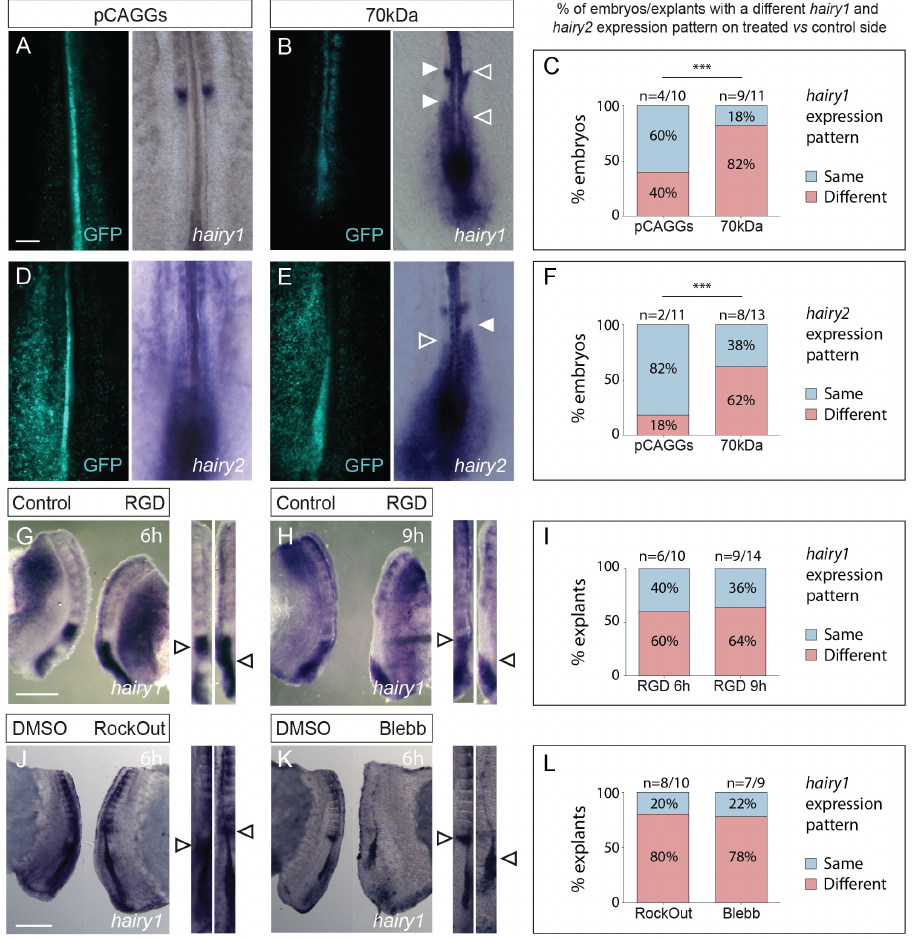
Figure 6. Perturbed segmentation clock dynamics in 70 kDa-electroporated embryos and explants cultured with RGD, RockOut or Blebbistatin, evidenced by altered hairy1 or hairy2 expression patterns. In situ hybridization for hairy1 ( A , B ) and hairy2 ( D , E ) on pCAGGS- ( A , D ) and 70 kDa-electroporated ( B , E ) embryos and on explant pairs testing the effect of RGD ( G , H ), RockOut ( J ) or Blebbistatin ( K ). Straightened images of paraxial mesoderm of contralateral explant pairs were aligned by SIV (right, G , H , J , K ) to determine if the phase of the hairy1 expression cycle was the same in the two contralateral sides. Rostral is on top. Quantification of the percentage of PSM pairs which are in a different phase of hairy1/2 expression ( C , F , I , L ). Example of a pCAGGs-electroporated control with the same hairy1 ( A ) and hairy2 ( D ) expression pattern on both sides of the PSM. The 70 kDa-electroporated embryos with different hairy1 ( B ) and hairy2 ( E ) expression patterns on the electroporated sides (left) (solid vs open arrowheads in B , E ). The percentage of 70 kDa-electroporated embryos with altered hairy1 ( C ) and hairy2 ( F ) expression patterns is significantly higher than in controls (pCAGGs) ( C , F ). Examples of hairy1 expression patterns in RGD-treated explants after 6 ( G ) or 9 h ( H ) of culture. In total, 60%–64% of RGD-treated explants display different hairy1 patterns than their contralateral control sides (arrowheads in G , H , I ). In RockOut- ( J ) and Blebbistatin-treated ( K ) explants, 80% and 78%, respectively, displayed different hairy1 expression compared to their contralateral control (DMSO) explants after 6 h of culture (arrowheads in J , K , L ). p values were calculated using a chi-square test. Blebb—Blebbistatin. *** p < 0.001. Scale bars: 200 µ m ( A – E ), 500 µ m ( G – K